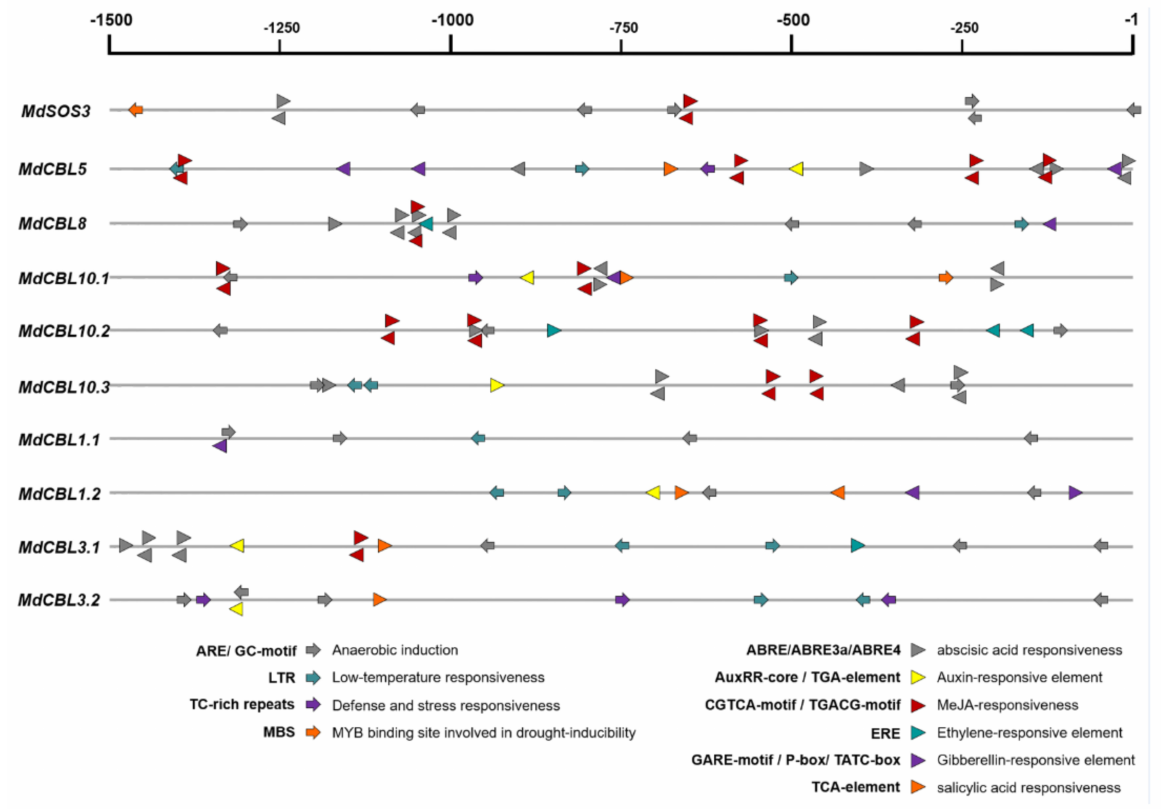
Figure 3. Cis -element analysis of the MdCBL gene promoter regions in apple. Arrows and triangles indicate the cis -elements related to abiotic stress response and hormone response, respectively. Positive and negative directions indicate whether the motif existed in the plus or minus strand of the cis -acting elements,